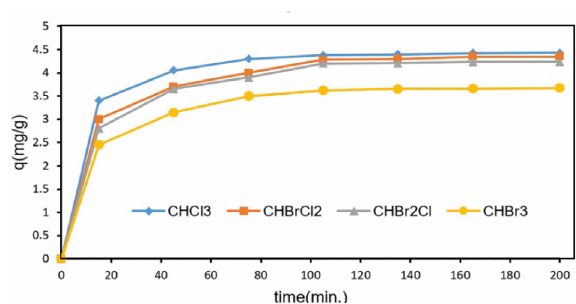
Figure 6B. Adsorption capacity of THMs over the time at the initial concentration of 0.5 mg/L and 10 mg adsorbent at 20 °C